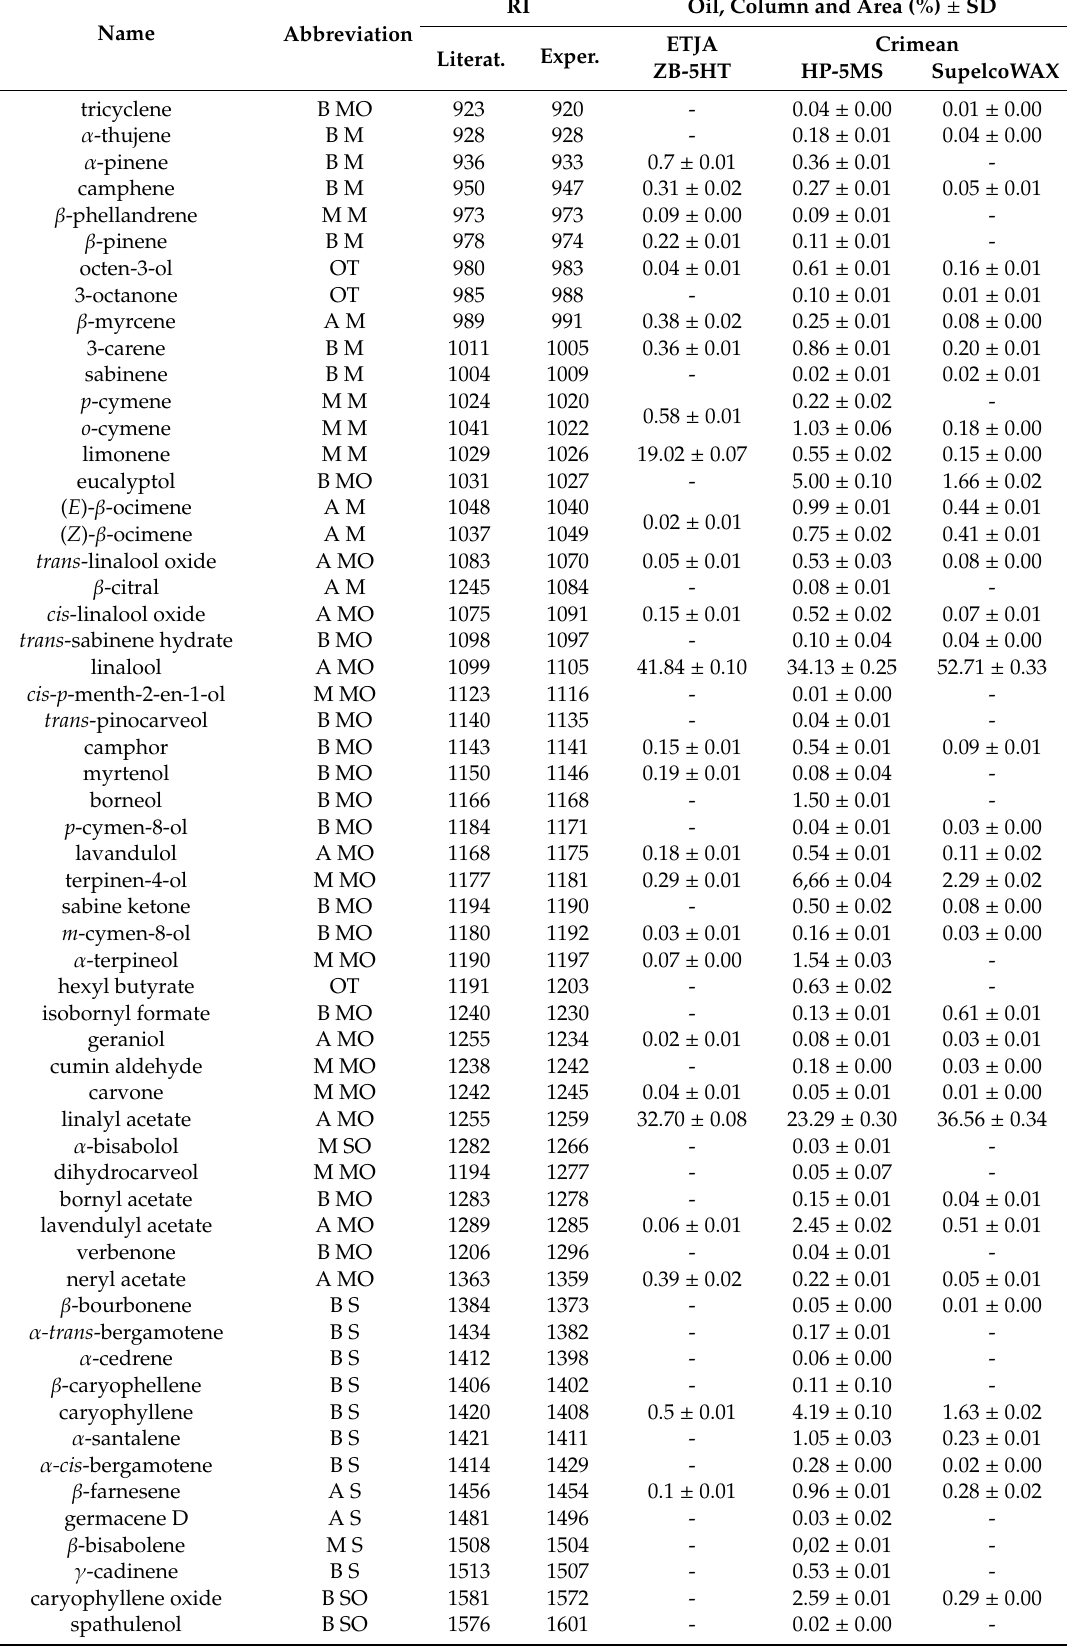
Table 3. The components of ETJA and Crimean lavender